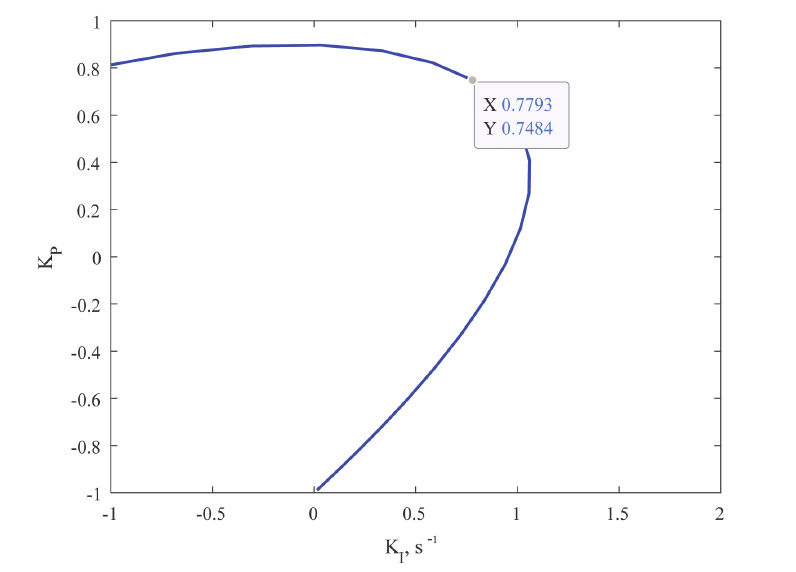
Figure 7. The stability region for single-area LFC